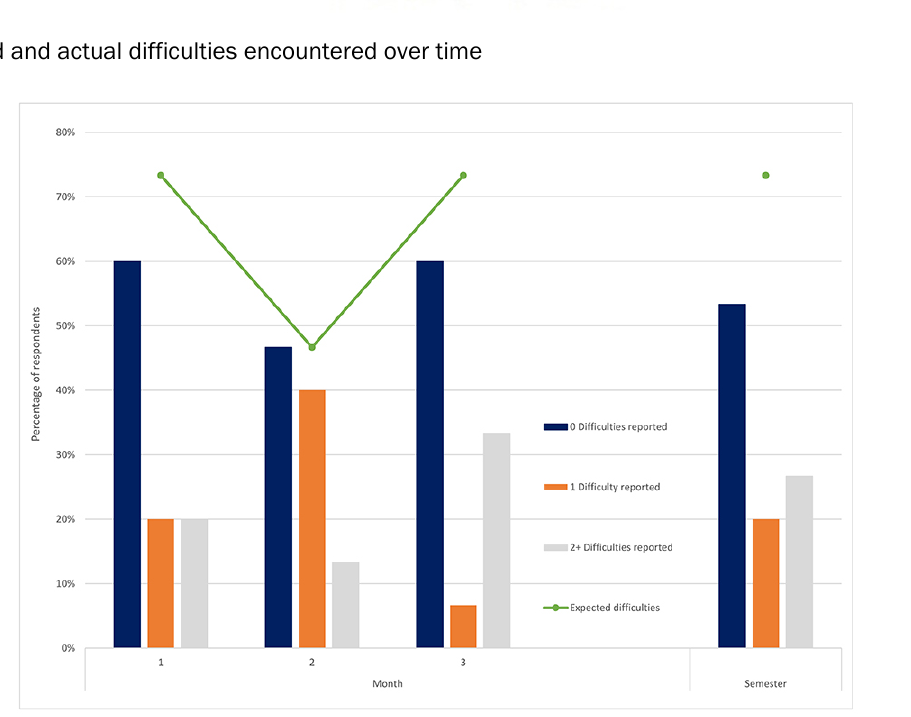
Figure 2 Expected and actual difficulties encountered over time